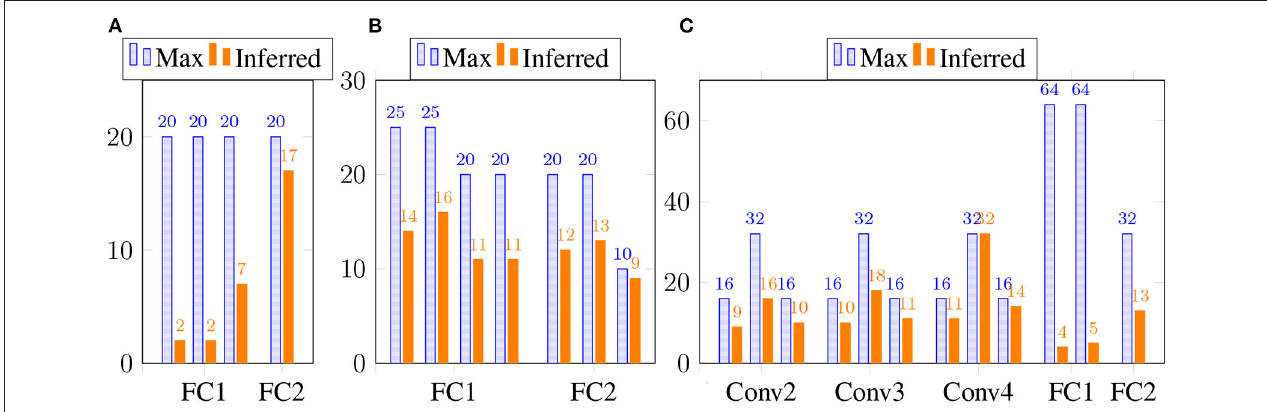
FIGURE 1 | The inferred TT rank at different layers. (A) 2 TT-FC layers for Fashion-MNIST. (B) 2 Tucker-FC layers for Fashion-MNIST. (C) 4 TT-Conv and 2 TT-FC layers for